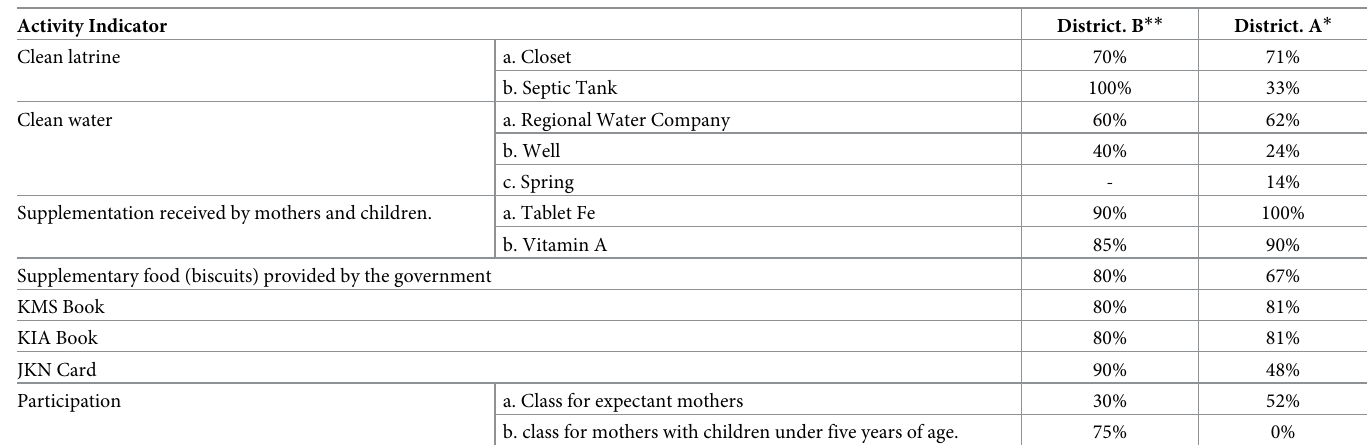
Table 3. Implementation of stunting prevention activities in households with stunting